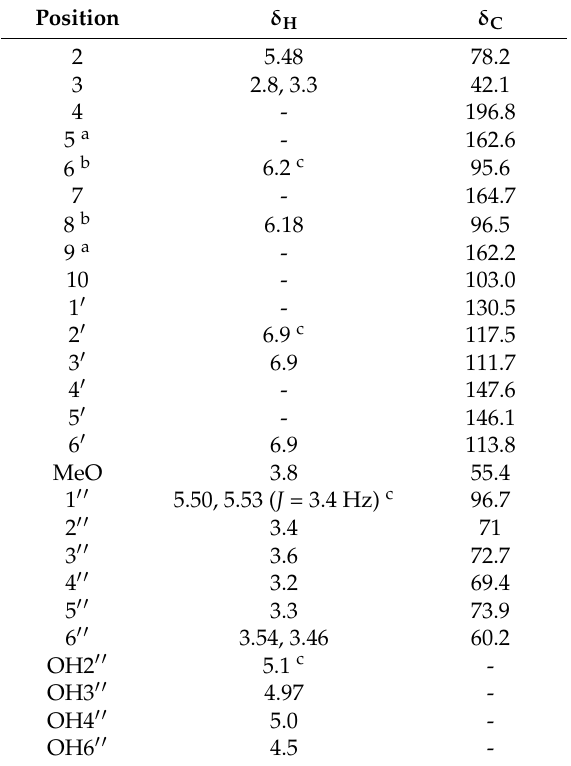
Figure 3. Chemical structure of hesperetin 7- O - α - D -glucopyranoside. Table 1. NMR Spectroscopic Data (600 MHz, DMSO- d 6 ) for hesperetin 7- O - α - D -glucopyranoside. Data obtained from HSQC and HMBC spectra.